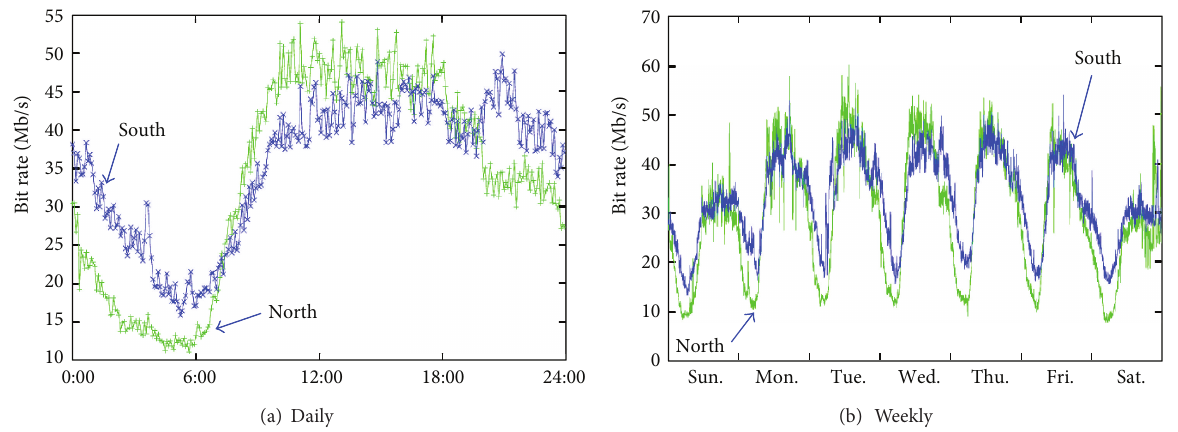
Figure 1: Byte volume on a domestic link in each direction (north/south)—source